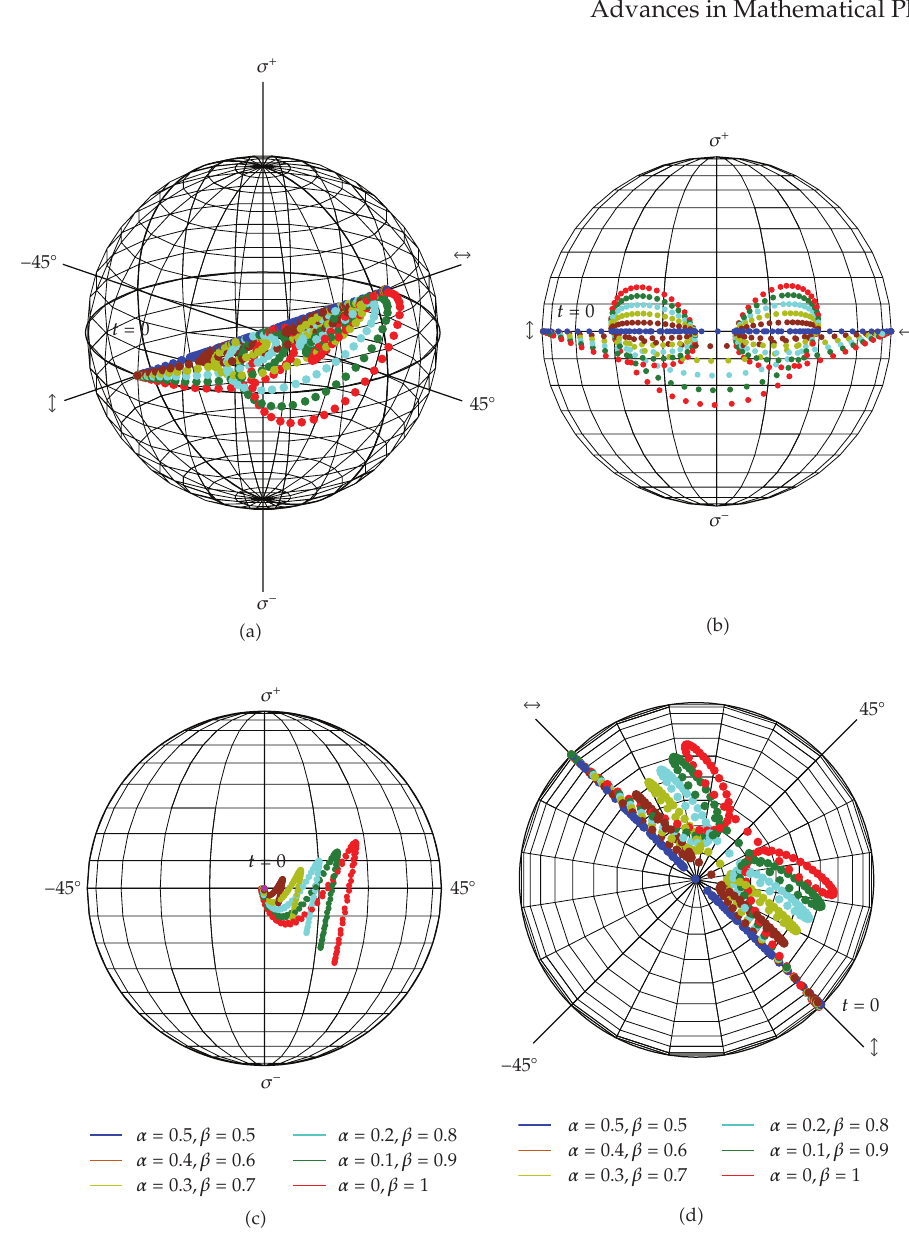
Figure 6: Photon polarization dynamics on the poincare sphere for small Δ